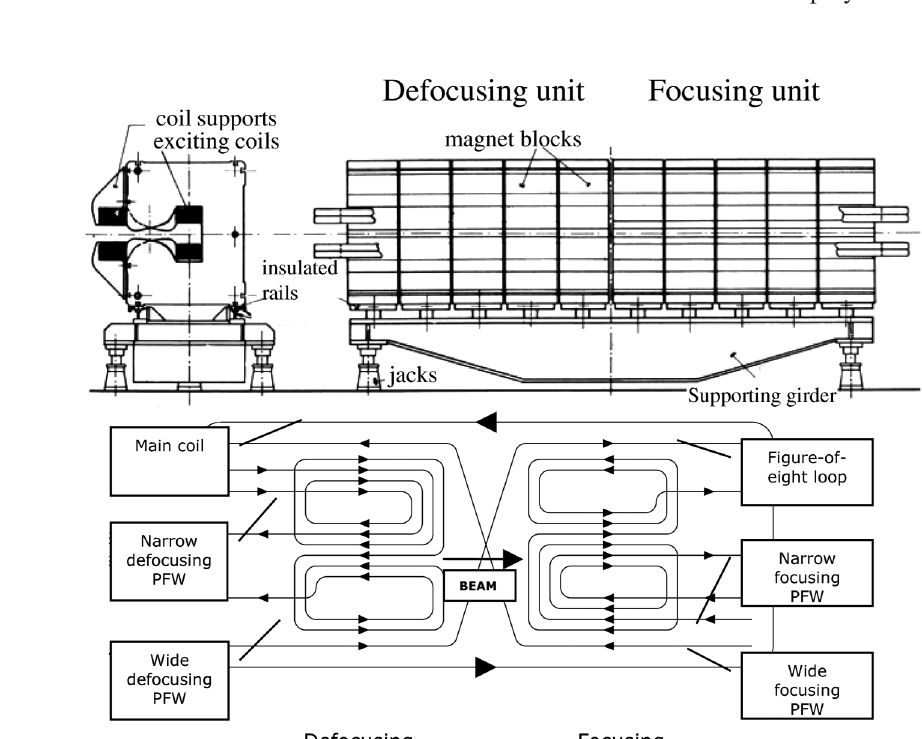
FIG. 1. Sketch of PS main magnet (upper) and of the five circuits used to control the tunes and the chromaticities